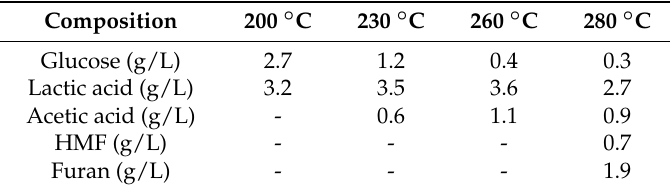
Table 4. The main organic compounds in